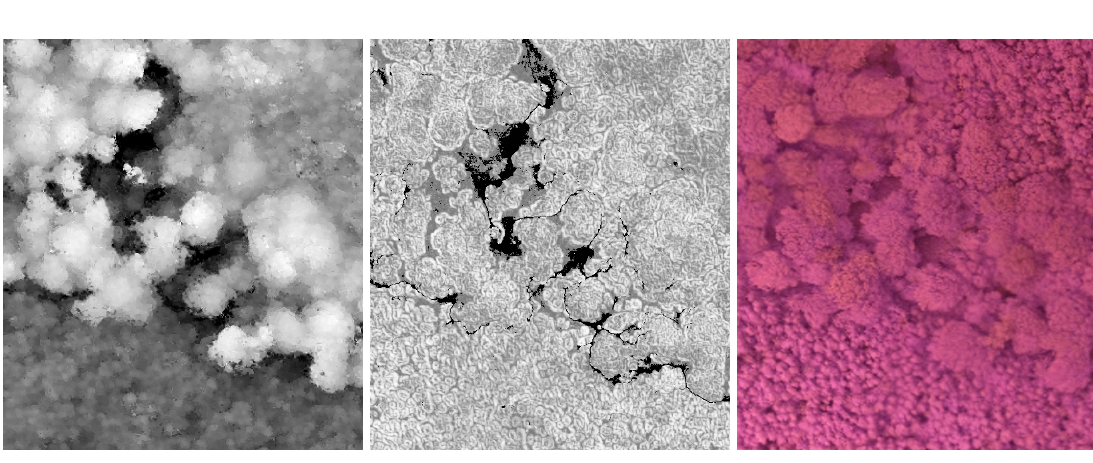
Figure 4. Close-up of the canopy surface model. ( Left ) The canopy surface model; ( Center ) map of the normalized cross-correlation score, expressing the similarity of the images (the normalized cross-correlation score ranges from zero (dark area, low similarity) to one (white area, high similarity)); ( Right ) false color ortho-photo